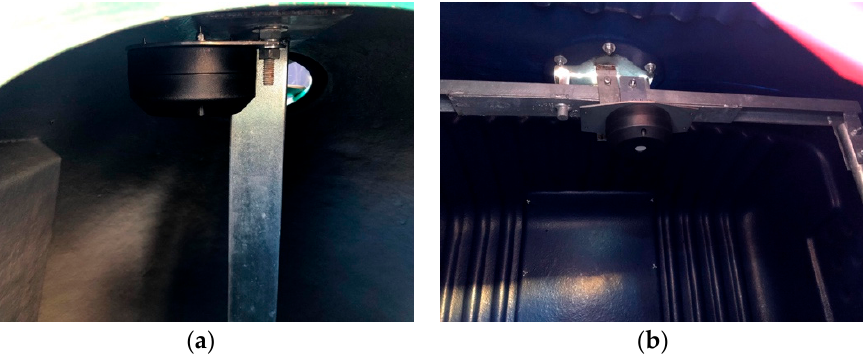
Figure 7. Dingtek DF702 installed in the containers: ( a ) installed in an Iglô; ( b ) installed in the Cyclea.